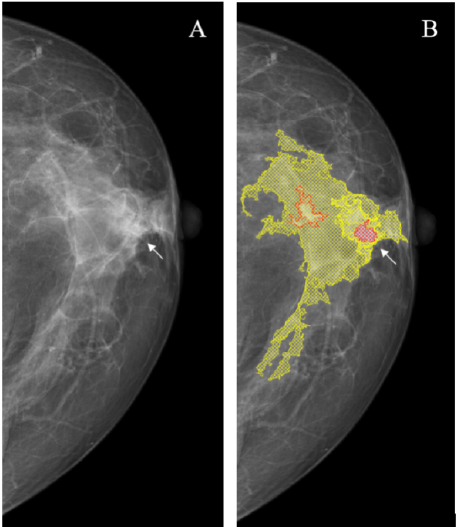
Figure 9. Changes poorly visible or invisible on the dense parenchyma background (arrow). ( A ): Source image; ( B ): NCA outcome. The YOLOv4 did not mark the lesion.